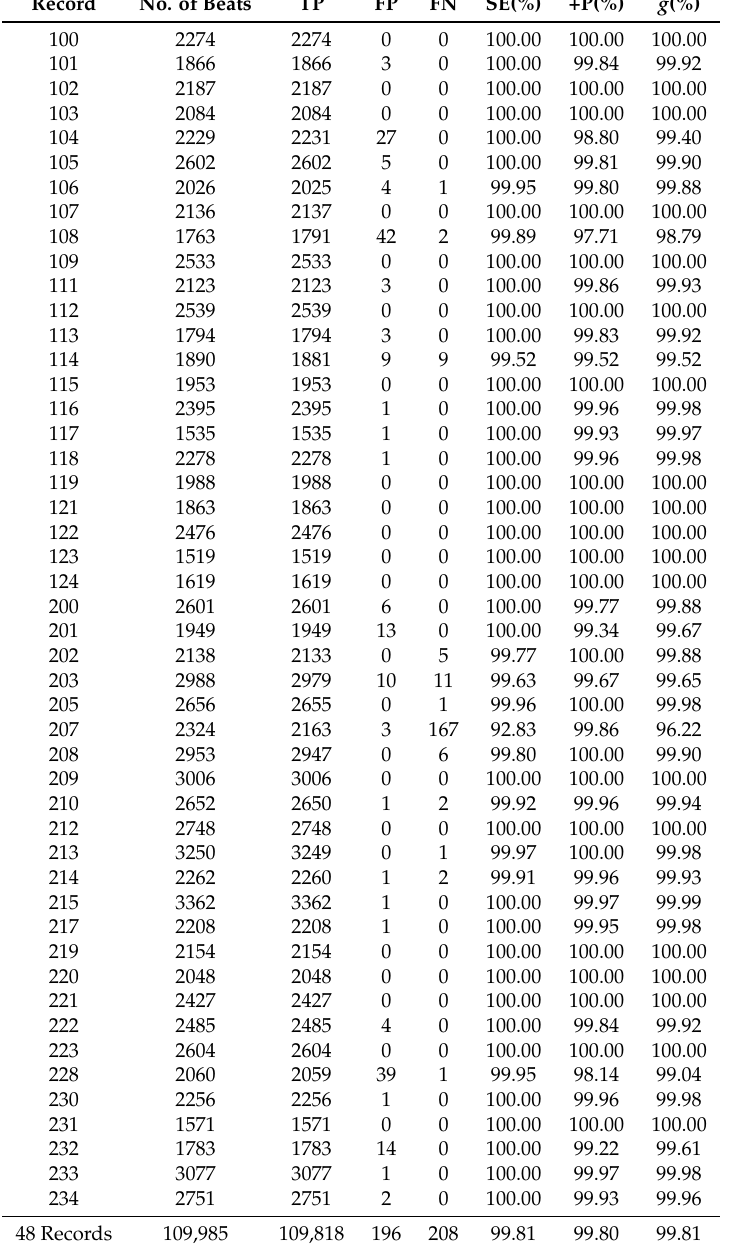
Table 2. Performance of the proposed compression of Method III using the MIT-BIH Arrhythmia Database. The results were obtained using the optimal value of K = 60 Hz. TP stands for true positives (QRS complexes detected as QRS complexes), FN stands for false negatives (QRS complexes that have not been detected), FP stands for false positives (non-QRS complexes detected as QRS complexes), SE stands for sensitivity, and + P stands for positive